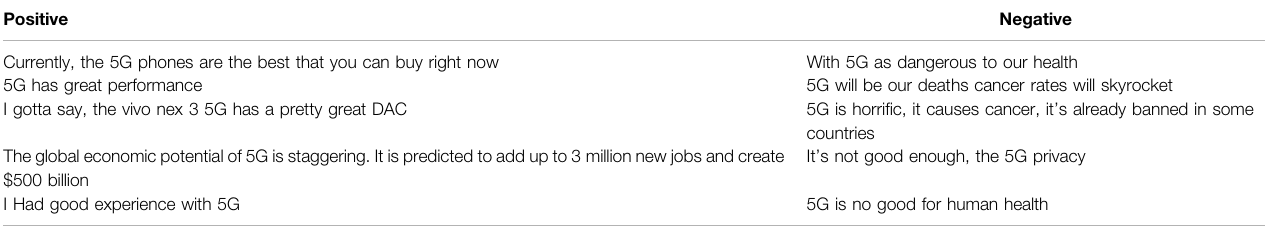
TABLE 7 | Examples of positive and negative tweets towards the next generation mobile network (5G). Positive